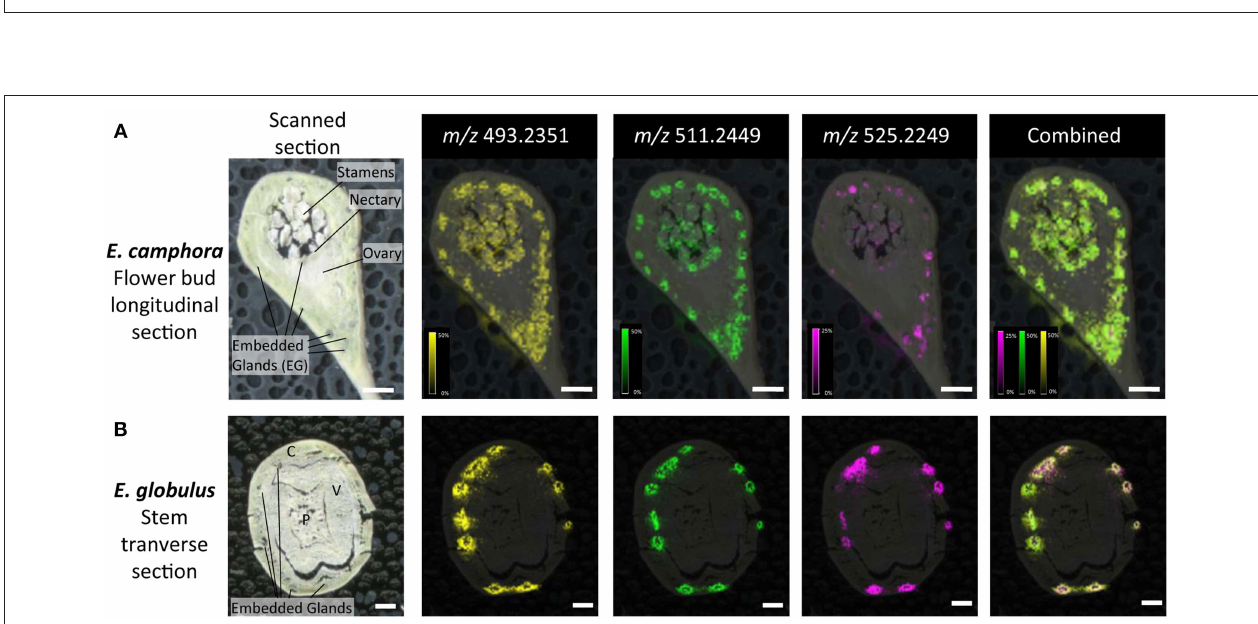
FIGURE 6 | Localization of FPCs in Eucalyptus camphora flower bud (A) and E. globulus stem (B) . A longitudinal section of a flower bud and transverse section of a stem were prepared for matrix-assisted laser desorption ionization-mass spectrometry imaging (MALDI-MSI). Corresponding ion maps of different FPCs are shown: yellow; m/z 493.2351; [M + K] + , green m/z 511.2449; [M + K] + , pink m/z 525.2249; [M + K] + , and a combination of all selected ions overlaid. FPCs are associated to the embedded glands, adjacent to the epidermis of the flower bud, to the embedded glands beneath the nectary, and to the stamens. For the stems, FPCs are localized to embedded glands within the cortex. All images are root mean square (RMS) normalized, with internal scaling of 50% for the ions m/z 493.2351 and 511.2449, and 25% for m/z 525.2249. Scale bar = 500 µ M. C, cortex; P, pith; V, vascular tissue.